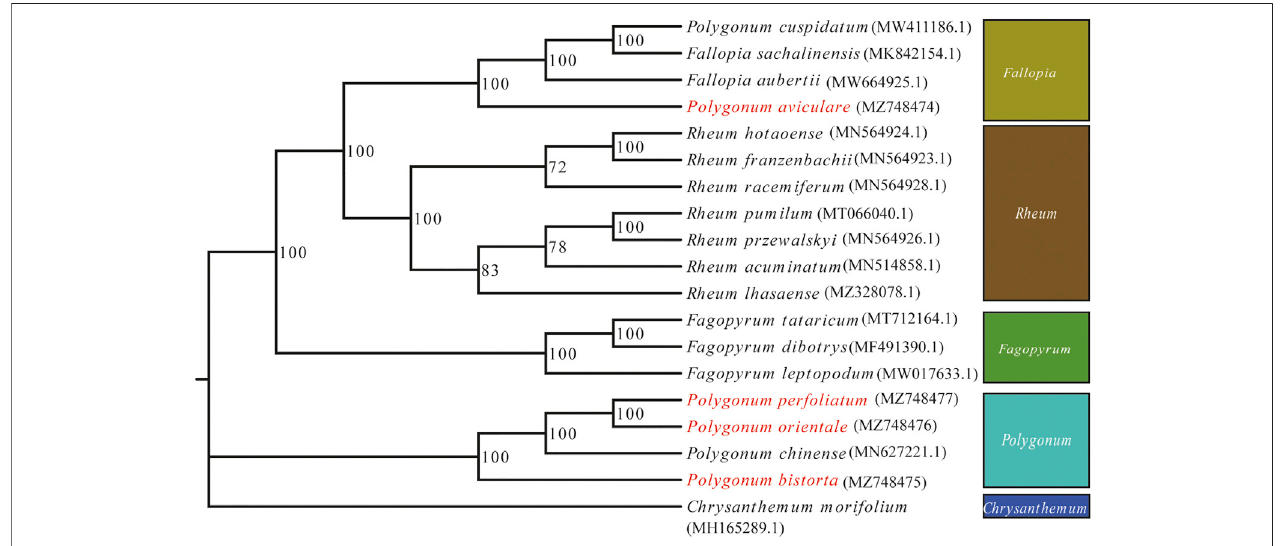
FIGURE 7 | ML phylogenetic tree reconstruction containing the cp genomes of 19 plants. Chrysanthemum x morifolium was set as the